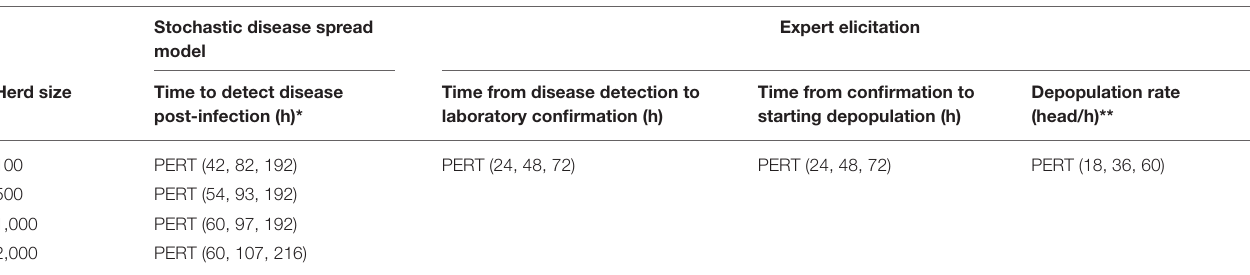
Expert elicitation